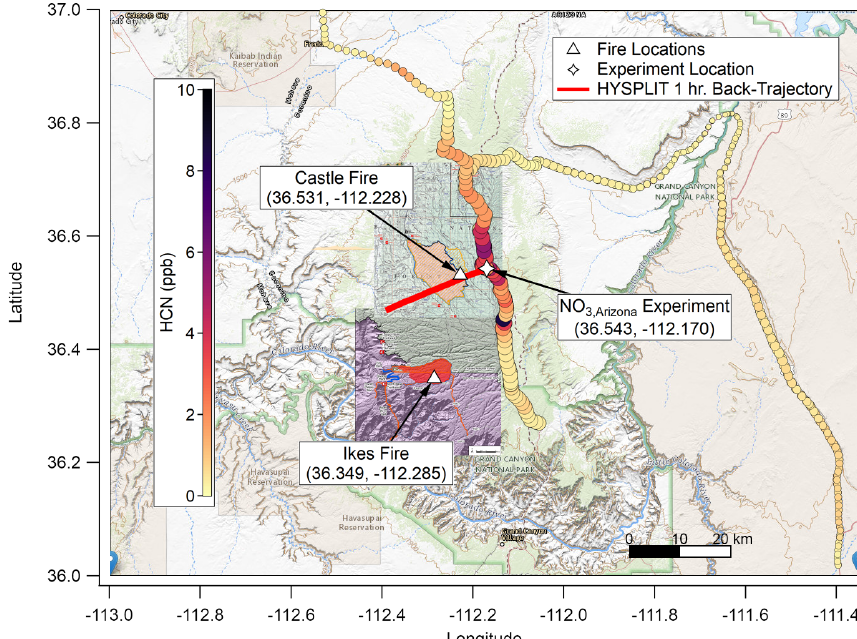
Figure 2. As with Fig. 1 but for NO 3 , Arizona on 22 August 2019. Based on HYSPLIT back trajectories, the plume for this experiment was again less than 1h old, though smoke that had settled in the valley under the nocturnal boundary layer may have been older. The background map is from USGS EarthExplorer, and fire map overlays are from the National Wildfire Coordinating Group’s Incident Information System